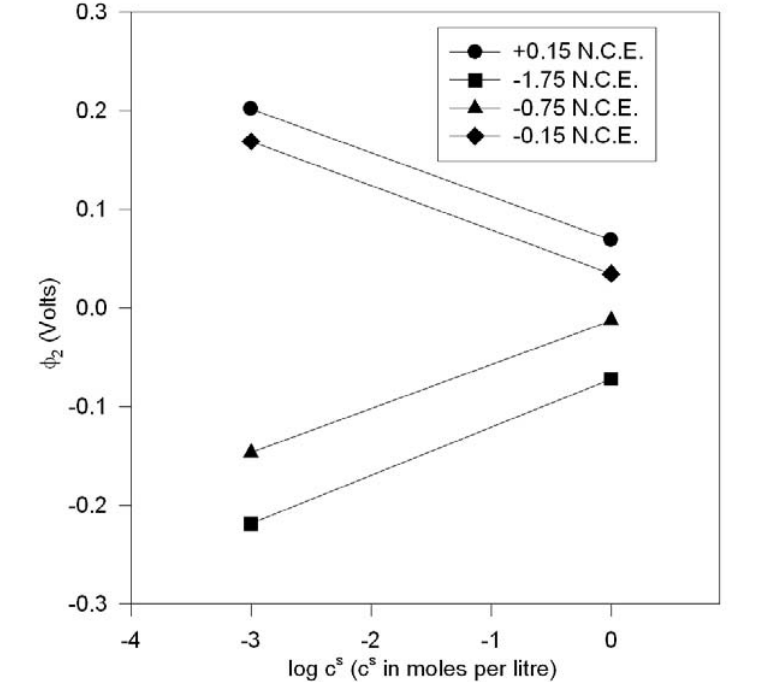
with bulk ionic 2